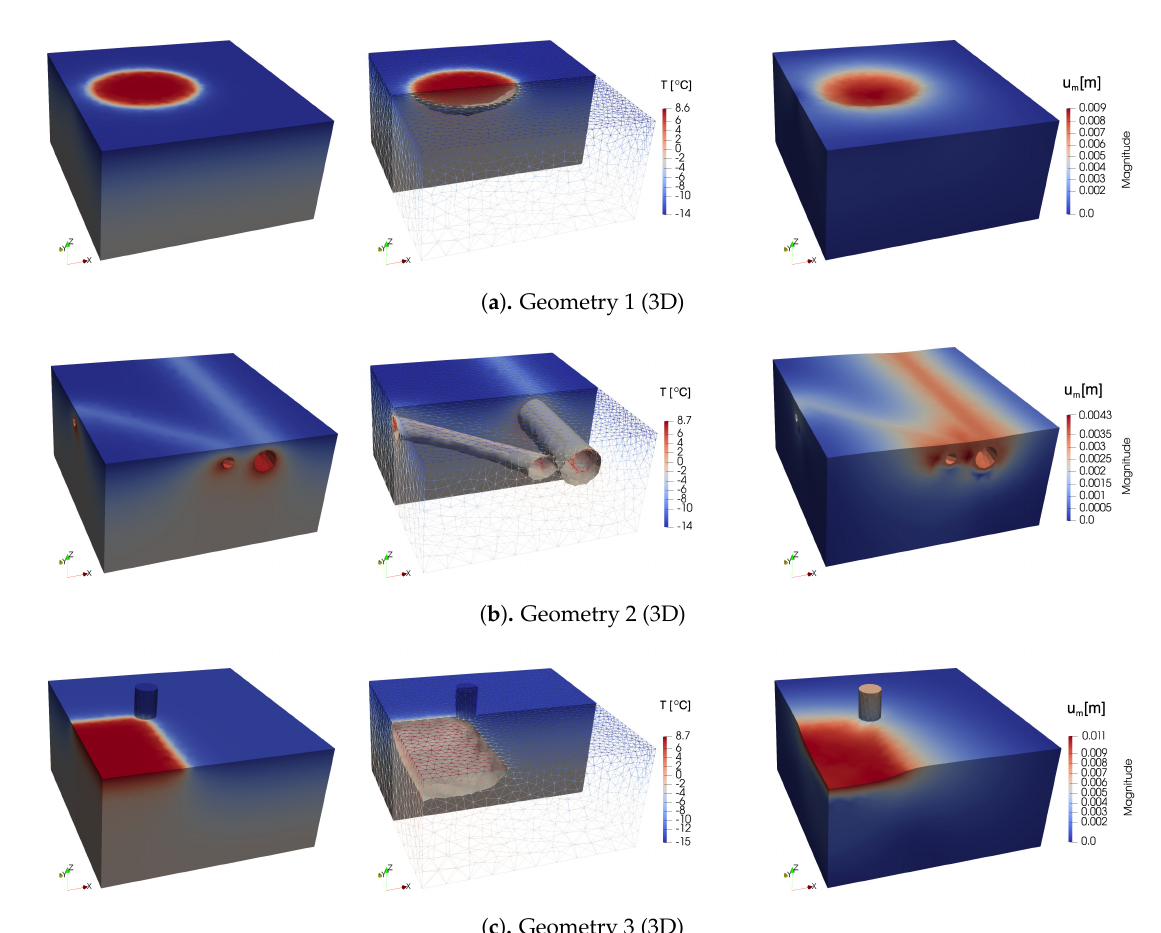
Figure 12. Test 1 for a three-dimensional problem. Temperature, temperature clip x 2 = L y /2 m with the phase change interface, and displacement fields at the final time (from left to right). Table 2. Calculation time in seconds with the corresponded number of iterations for three-dimensional problems. ∑ iter is the sum of Picard iterations over time. N t is the number of time steps. Method 1 and 2 are the linearization from